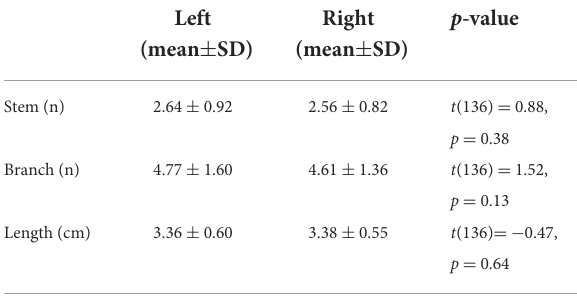
TABLE 1 The characteristics of LSA in the left and right hemispheres.